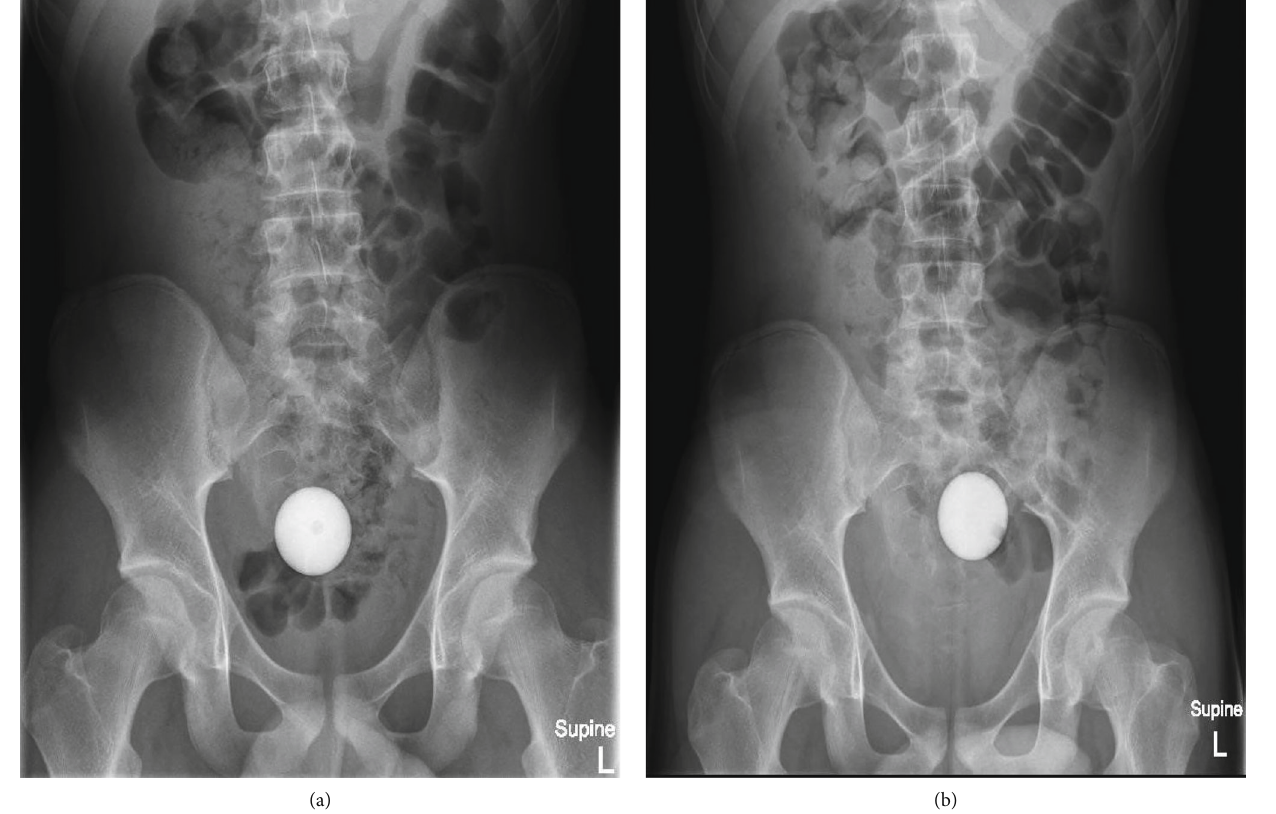
Figure 1: (a) Abdominal X-ray on admission demonstrating the golf ball within the upper rectum. (b) Abdominal X-ray on day 1 inpatient demonstrating proximal migration of the golf ball into the sigmoid